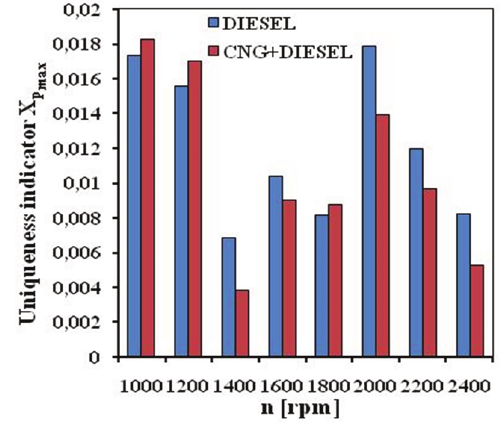
Fig. 8. Comparison of the value of the uniqueness indicator for the maxi- mum pressure of the combustion process of the operating cycle of the Perkins 1104D-E44TA engine operating according to external speed characteristics, in dual-fuel operation, powered by CNG + Diesel and by diesel fuel only